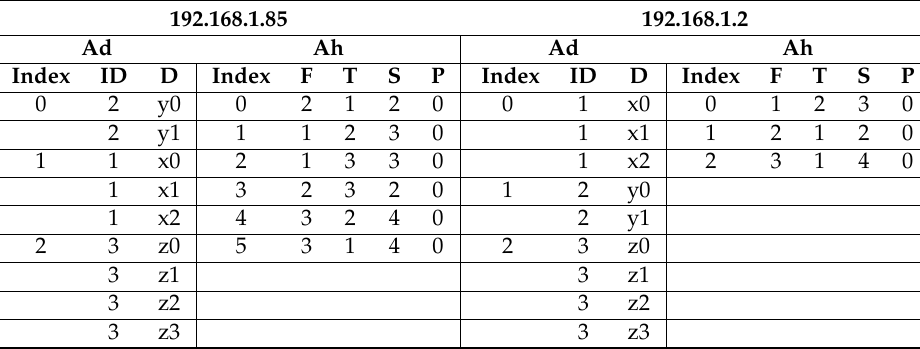
Table 5. Data transfer between Ro 2 and Ro 1 , sending data from Ro 3 .